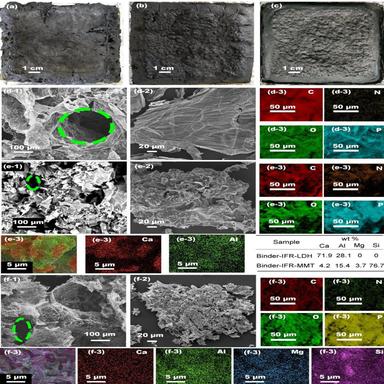
Photographs of char layers derived form (a) Binder-IFR, (b) Binder-IFR-LDH, and (c) Binder-IFR-MMT. SEM and SEM-EDS maps of char layers derived from (d) Binder-IFR, (e) Binder-IFR-LDH, and (f) Binder-IFR-MMT. The EDS maps are shown in: (d-3) char layer of Binder-IFR, (e3) char layer of Binder-IFR-LDH, and (f-3) char layer from Binder-IFR-MMT. (A colour version of this figure can be viewed online.)